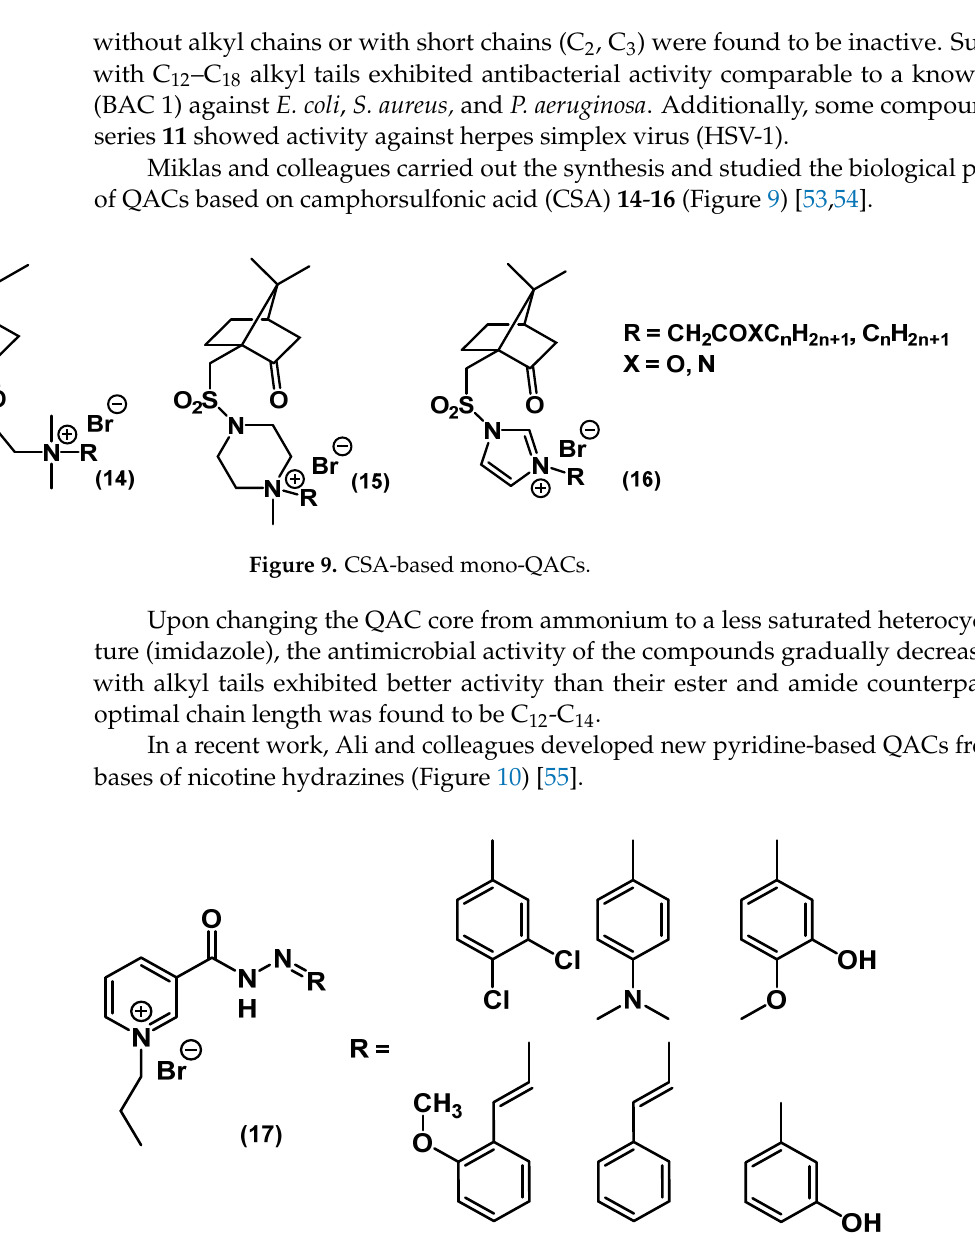
Figure 8. “Soft” mono-QACs.